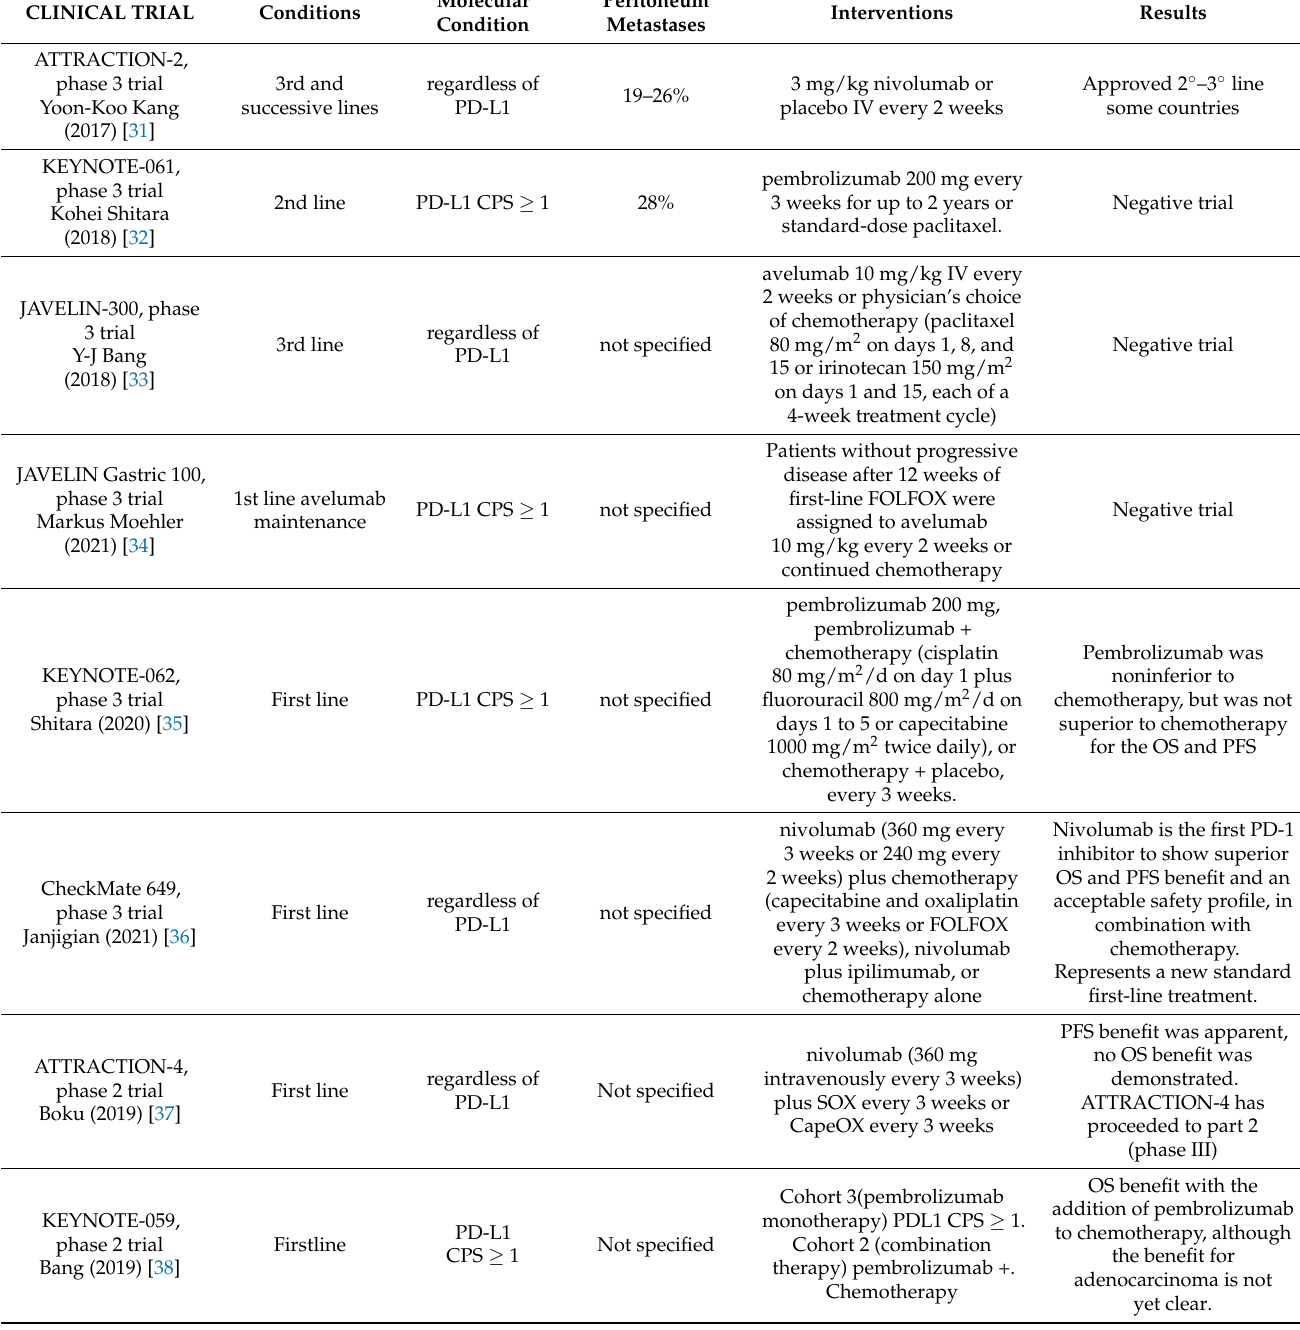
Table 1. Summary of clinical trials with immunotherapy in advanced gastric or gastro-oesophageal junction cancer. CLINICAL